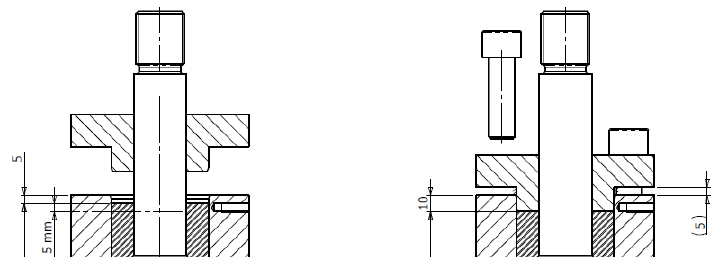
Figure 4. Prestressing of the lead core during the assembly of the PS-LED [41]. In order to investigate the effect of prestressing the lead, a simplified numerical model of the PS-LED was formulated in the general-purpose software Abaqus/CAE 6.14-2 [38,42], using 4-node bilinear axisymmetric elements type C4X4. By taking advantage of the symmetry of the system about its longitudinal axis, only half of the prototype was